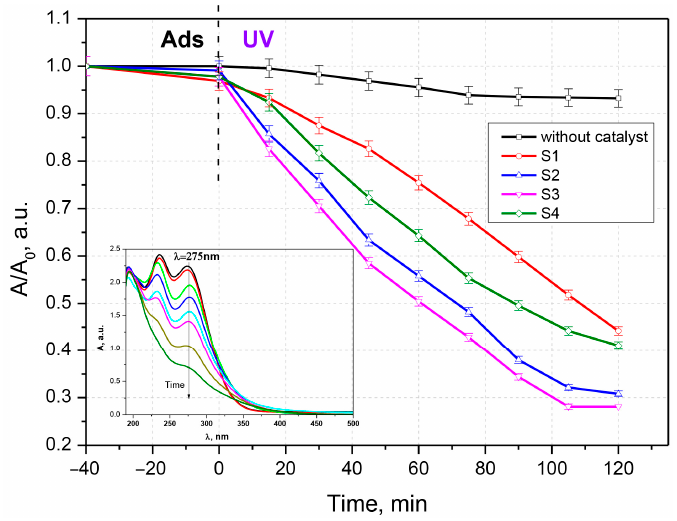
Figure 5. Photocatalytic degradation of chlortetracycline and time evolution of the UV-Vis absorption spectrum of chlortetracycline.